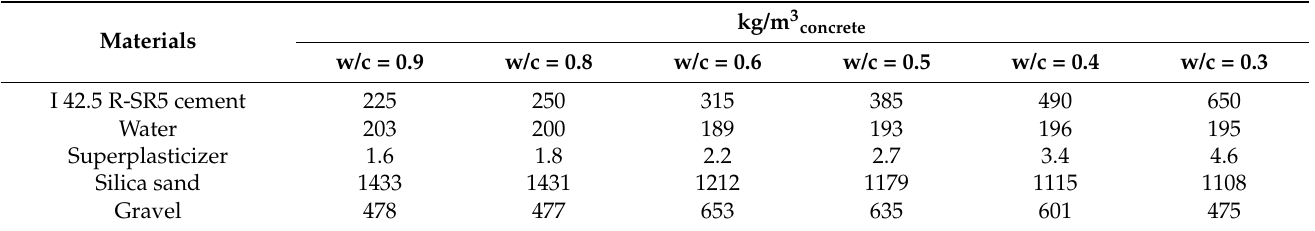
Table 1. Composition of the used